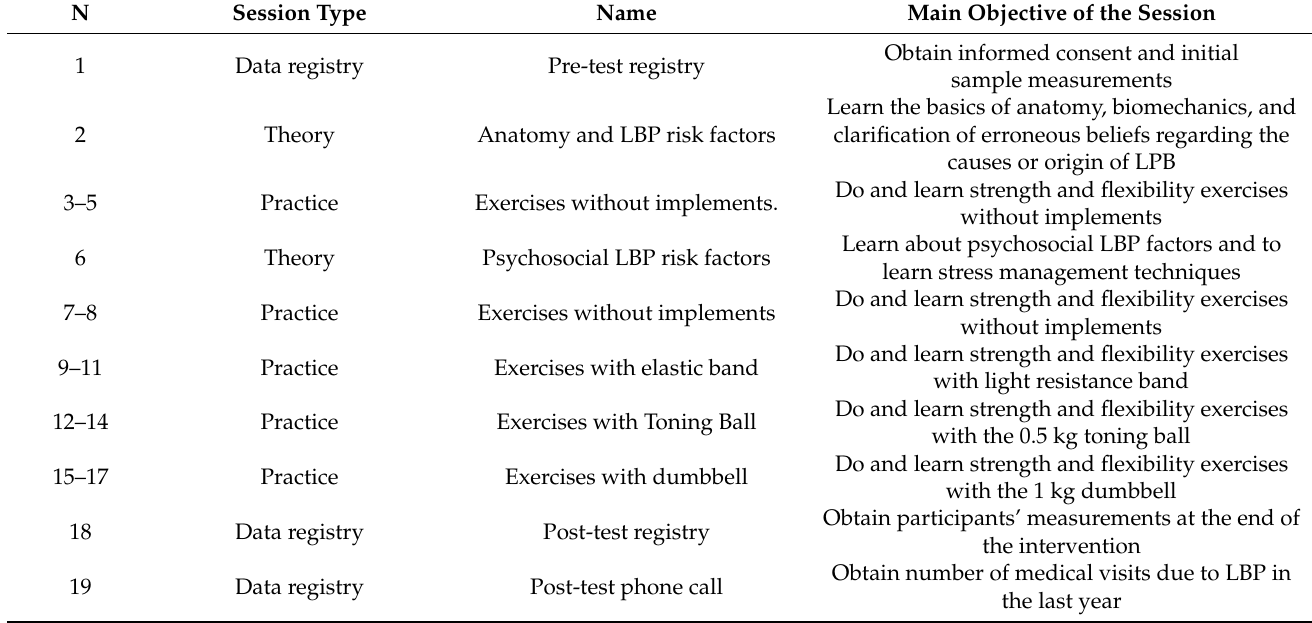
Table 1. Summary of the intervention and